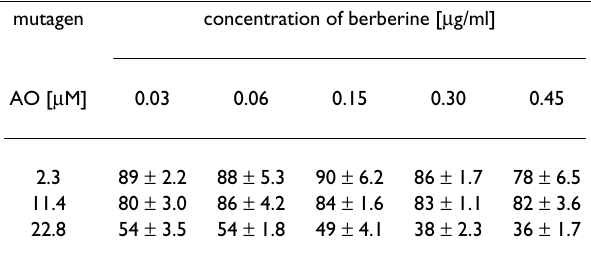
Table 1: Antimutagenic potency (AP) [%] of berberine in reduc- ing the acridine orange (AO)-induced bleaching of Euglena gracilis cells. mutagen concentration of berberine [ µ